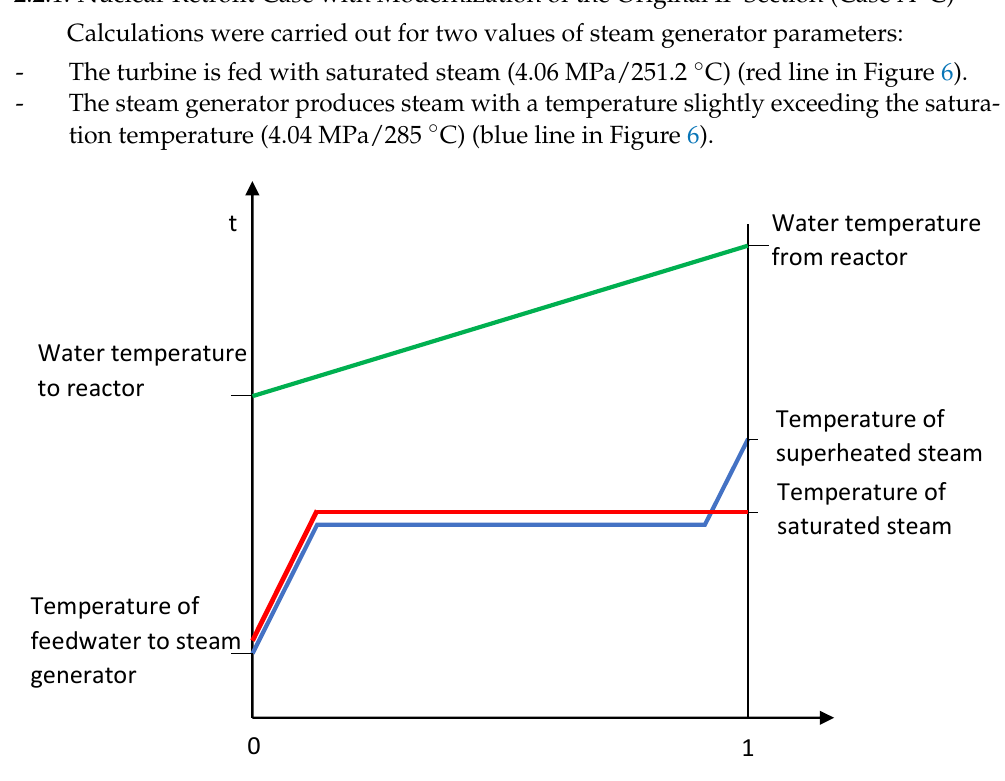
Figure 6. Temperature distribution in the steam generator (green line—temperature of water in the reactor coolant system, red line—temperature of working medium in the steam turbine cycle (case without superheater), bleu line—temperature of working medium in the steam turbine cycle (case with superheater).